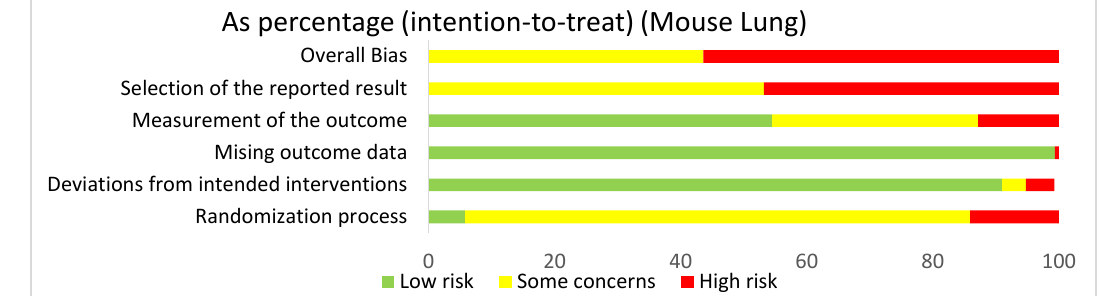
Figure 5. The overall bias for the studies regarding the lung utilizing mouse models was a high risk of bias (56.4%) and some concerns (43.6%). The selection of the reported result had a high risk of bias (46.8%) and some concerns (53.2%). The measurement of the outcome had a high risk of bias (12.8%), some concerns (32.7%), and low risk of bias (54.5%). The missing outcome data domain had a low risk of bias (99.4%) and a high risk of bias (0.6%). Deviations from intended interventions had a low risk of bias (91%), some concerns (3.8%), and high risk of bias (4.5%). The randomization process had a high risk of bias (14.1%), some concerns (80.1%), and low risk of bias (5.8%).